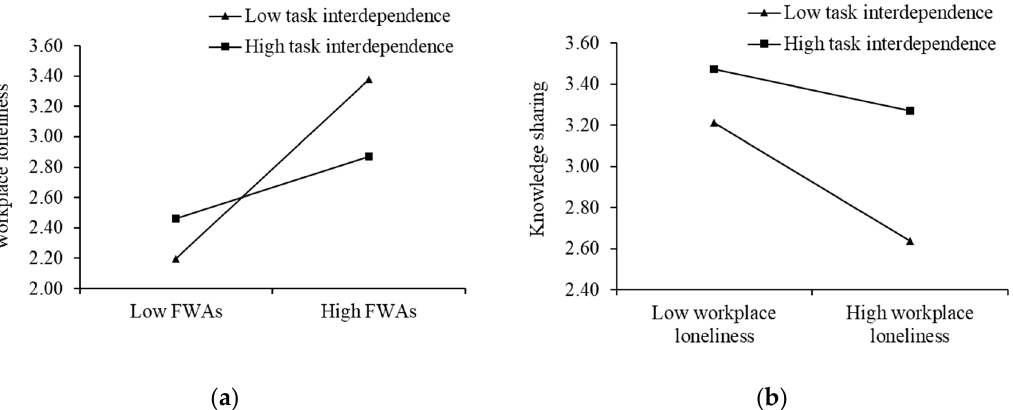
Figure 3. The moderating role of task interdependence in Study 2: ( a ) The moderating role of task interdependence on the relationship between FWAs and workplace loneliness; ( b ) The moderating role of task interdependence on the relationship between workplace loneliness and knowledge sharing.